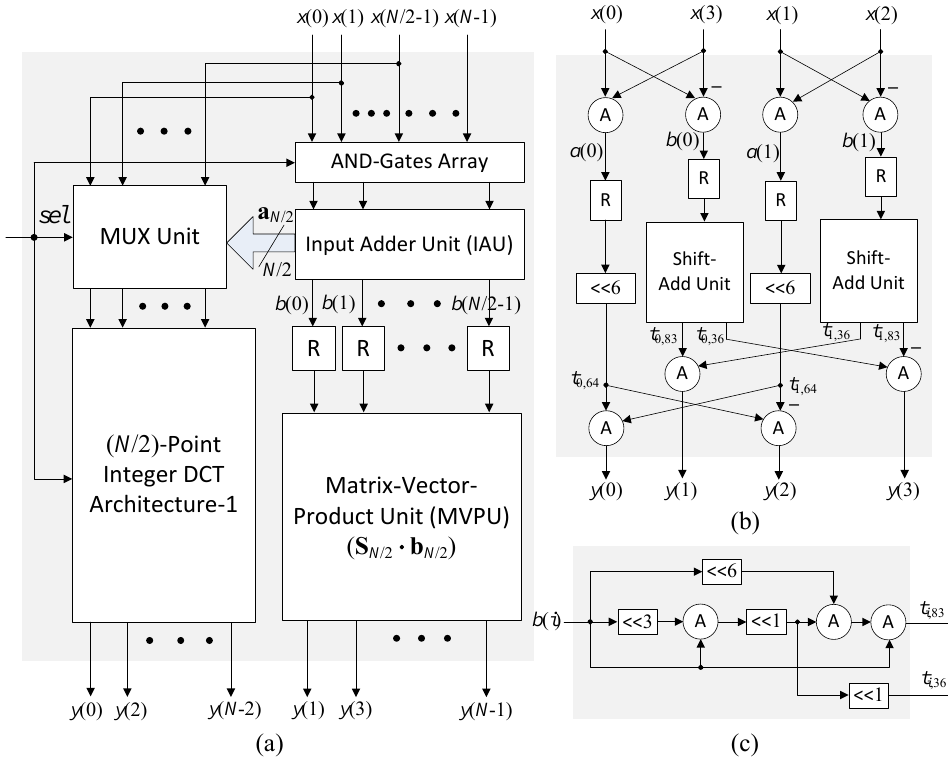
Figure 1. ( a ) Proposed Architecture-1 for N = 8, 16, and 32. ( b ) Four-point integer DCT architecture. ( c ) Shift-add unit used in ( b ). Table 2. Complexity comparison in terms of the number of adders. IAU, input adder unit.